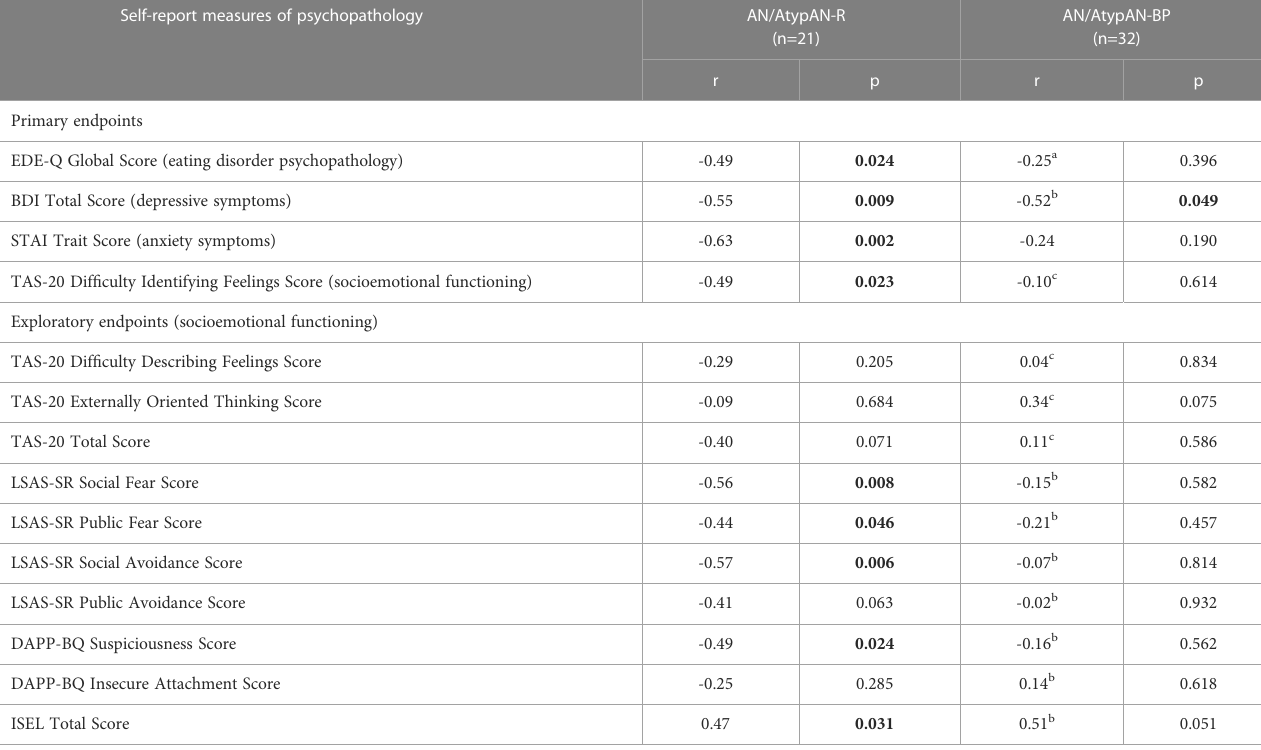
TABLE 3 Associations between (log-transformed) fasting oxytocin levels and psychopathology in women with anorexia nervosa (AN)/Atypical AN who are solely restricting (AN/AtypAN-R) versus those who restrict in combination with binge/purge behaviors (AN/AtypAN-BP). Self-report measures of